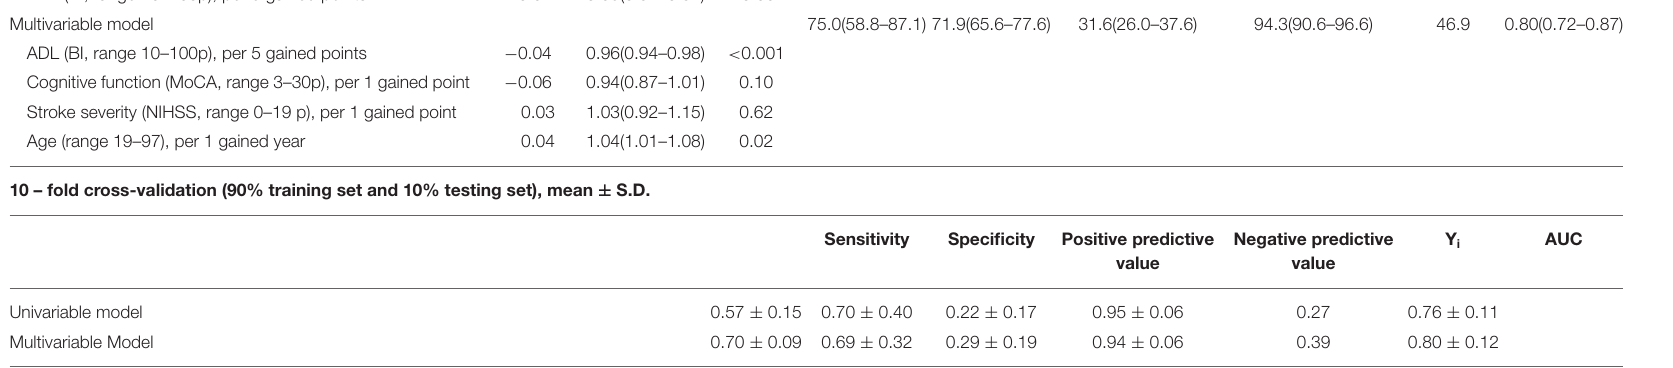
The results of tuned univariable and multivariable logistic regression models and 10-fold cross validation performed per respective model. Y i , Youden’s index (sensitivity (%) + specificity (%) – 100[or 1 for cross validated results]); ADL, personal activities of daily living; BI, Barthel index, the score in BI is increased with 5 points; MoCA, the Montreal Cognitive Assessment; NIHSS, the national institutes of health stroke scale; BI and MoCA were administered 36–48h after admission to the stroke unit. NIHSS, hospital admission point; BI and MoCA, a higher score indicates better outcome; NIHSS, a higher score indicates worse